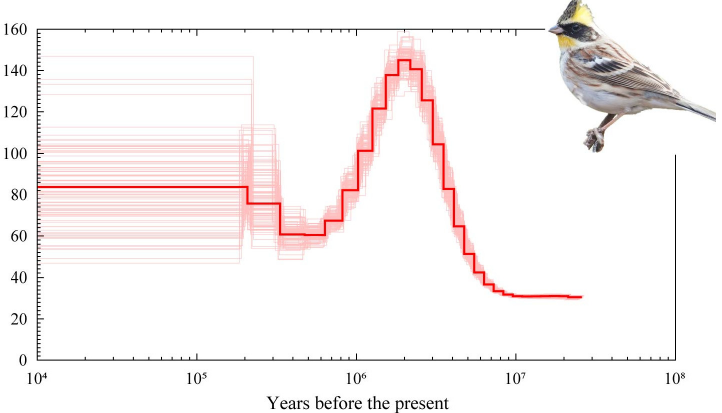
Figure 3. Demographic histories of yellow-throated bunting reconstructed using the PSMC model. The central red bold lines represent inferred population sizes, whereas thin lines are 100 individual bootstrap replicates.